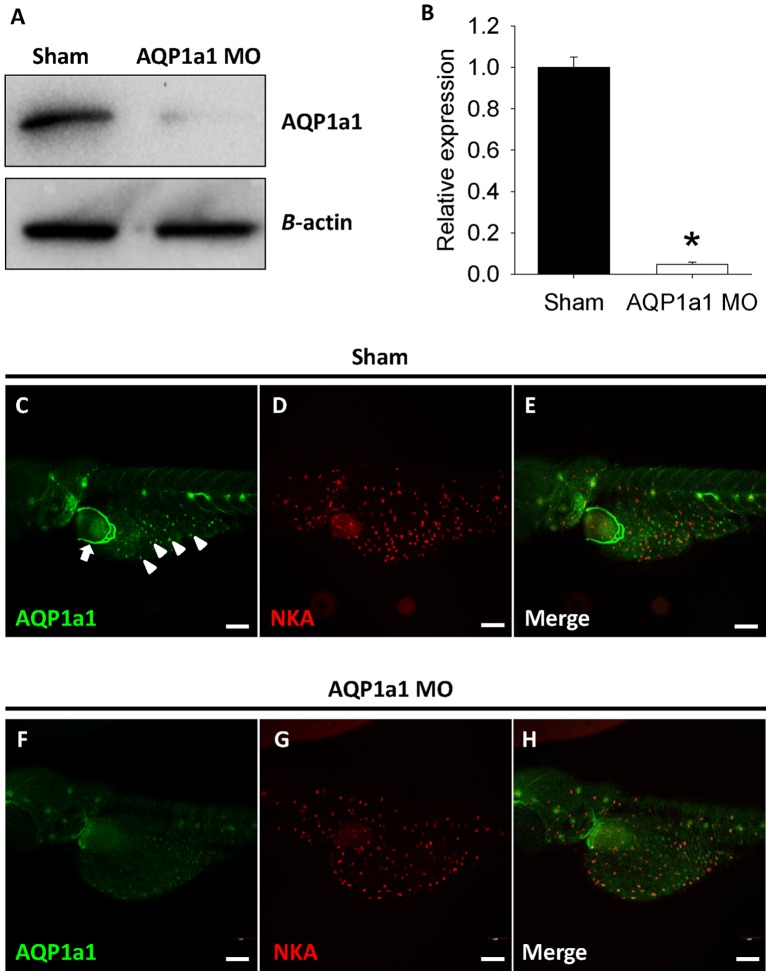
The protein expression of aquaporin-1a1 is reduced by morpholino knockdown.(A) A representative western blot showing the protein expression of aquaporin-1a1 (AQP1a1) in lysates of 4 dpf shams and AQP1a1 morphants (AQP1a1 MO) is reduced following morpholino knockdown. (B) Subsequent quantitative analysis revealed that the protein expression level of AQP1a1 in the morphants was significantly than shams (Student's t-test; p<0.05). Values are means ± SEM (n = 4). Fluorescent immunohistochemistry and confocal microscopy revealed the expression of (C) AQP1a1 (green; arrowhead) and (D) Na+/K+-ATPase (NKA; red) on the skin of yolk sac in the shams. AQP1a1 was also expressed in the red blood cells (Figure C; arrow). Figure (E) is a merged image of (C) and (D). (F) The expression of AQP1a1 was virtually absent in the morphants following the AQP1a1 knockdown. Figure (G) shows the expression of NKA, and Figure (H) is a merged images of (F) and (G). Scale bar  = 50 μm.